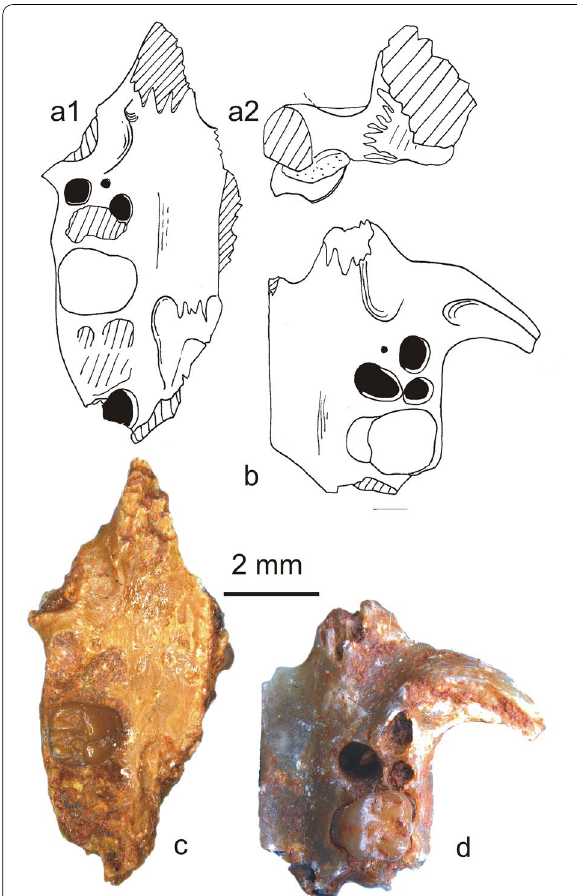
Fig. 22 Maxillary fragments of Protadelomys lugdunensis Hartenberger, 1969 from Laprade (Quercy). a (drawing), c (picture): LAP 224, right fragment; a1, palatine view showing the alveoli of D3 (single root) and DP4 (three roots; the erupting P4 is present underneath), M1 only preserved; a2, showing the base of the wide opening of the i.o.f., in frontal view. b (drawing), d (picture): LAP 83, left fragment in palatine view, with the alveoli of D3 and probably that of P4 and not DP4, as the M1 is more worn than on LAP